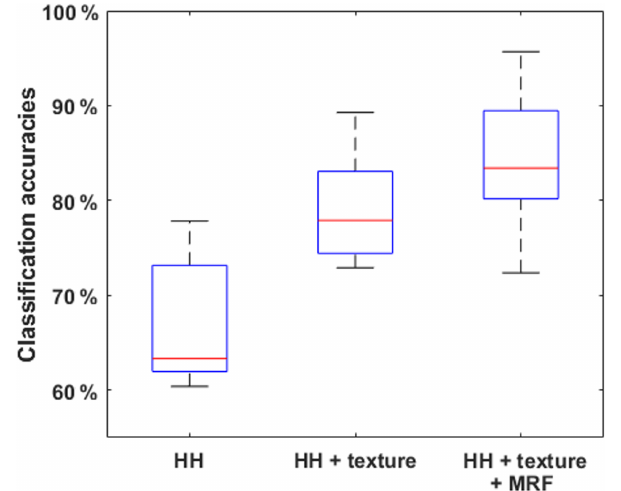
Figure 7. Overall accuracies for sea ice classification derived from testing scenes based on TSX SC HH intensities and on HH intensi- ties and GLCM textures with and without MRF